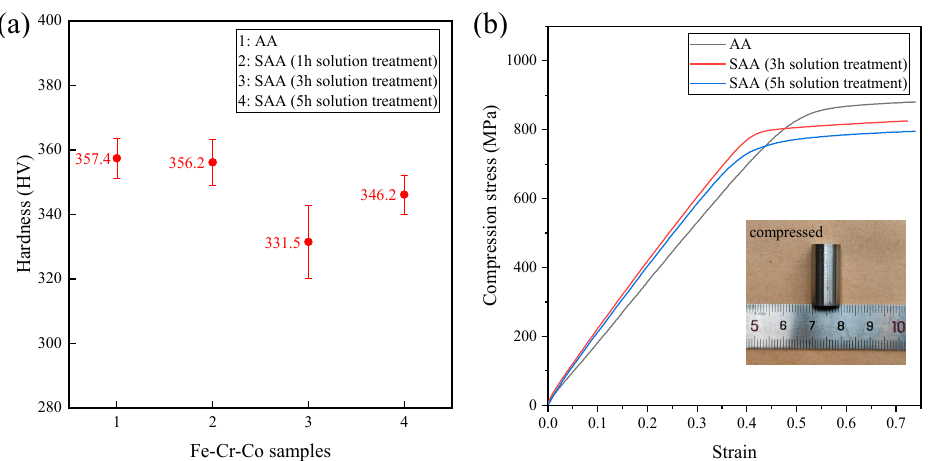
Figure 10. ( a ) Average microhardness in hardness tests and ( b ) deformation curves in compression tests of Fe-25Cr-15Co samples.